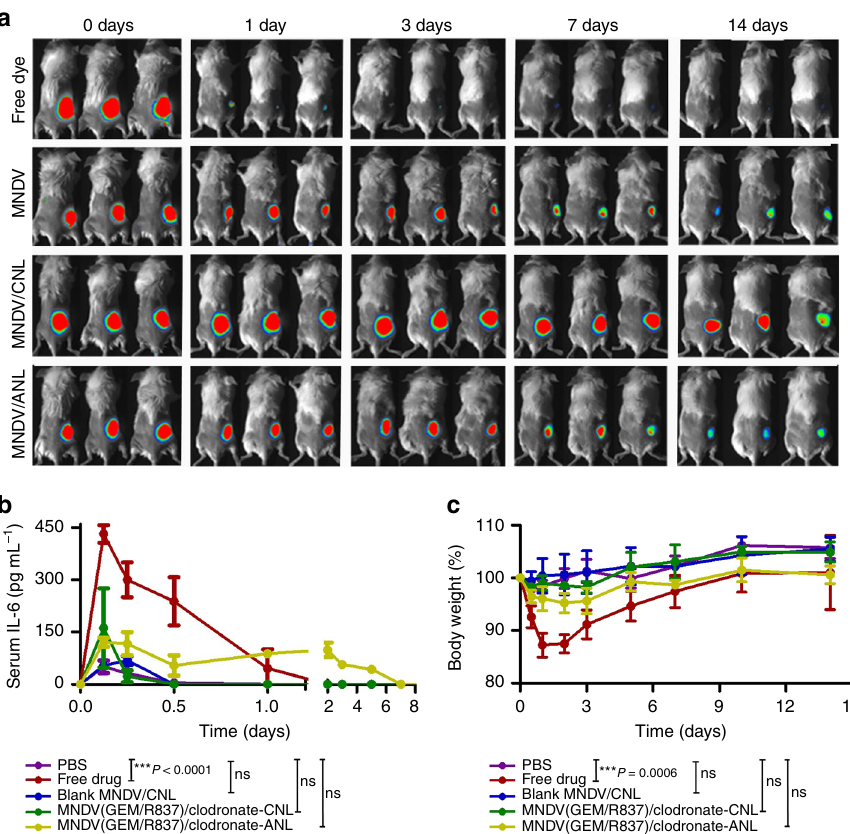
Fig. 2 Extended release of drugs from localized iGel can reduce systemic toxicity. a Fluorescence imaging depicting the retention of IR dye-labeled MNDVs after treatment. b Serum levels of IL-6 and c percentage of body weight change following subcutaneous administration of different treatment groups. Data are presented as the means ± S.D. ( n = 4). P -values were analyzed by one-way ANOVA and Tukey ’ s test (serum IL-6 data at 3 h and body weight data at day 1). The results are representative of one of two independent experiments. Source data are provided as a Source Data fi